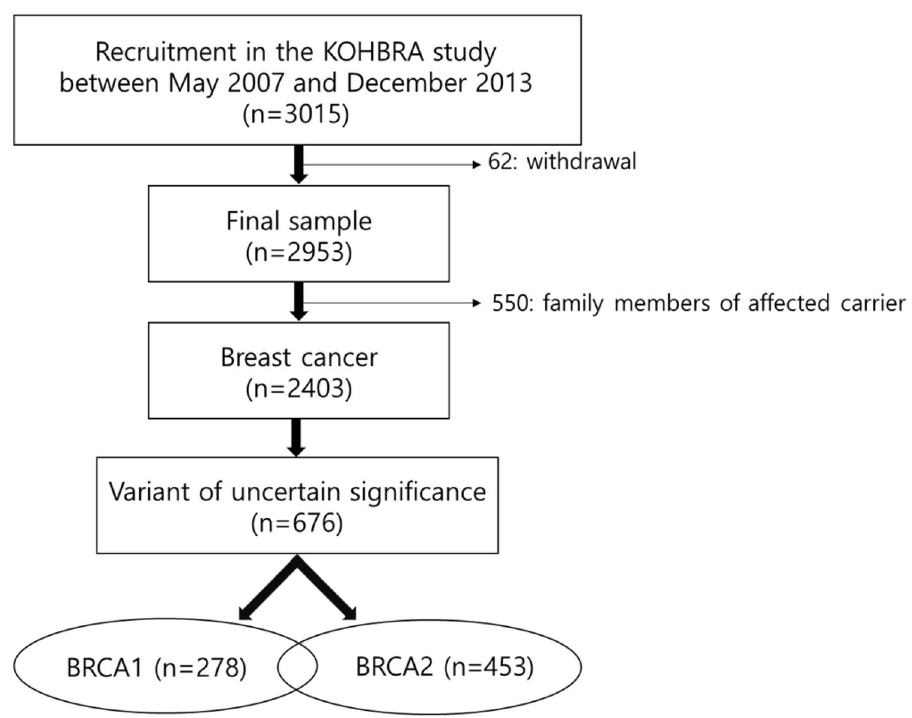
Figure 1. Schematic diagram of patient selection: BRCA1 and BRCA 2 (n =